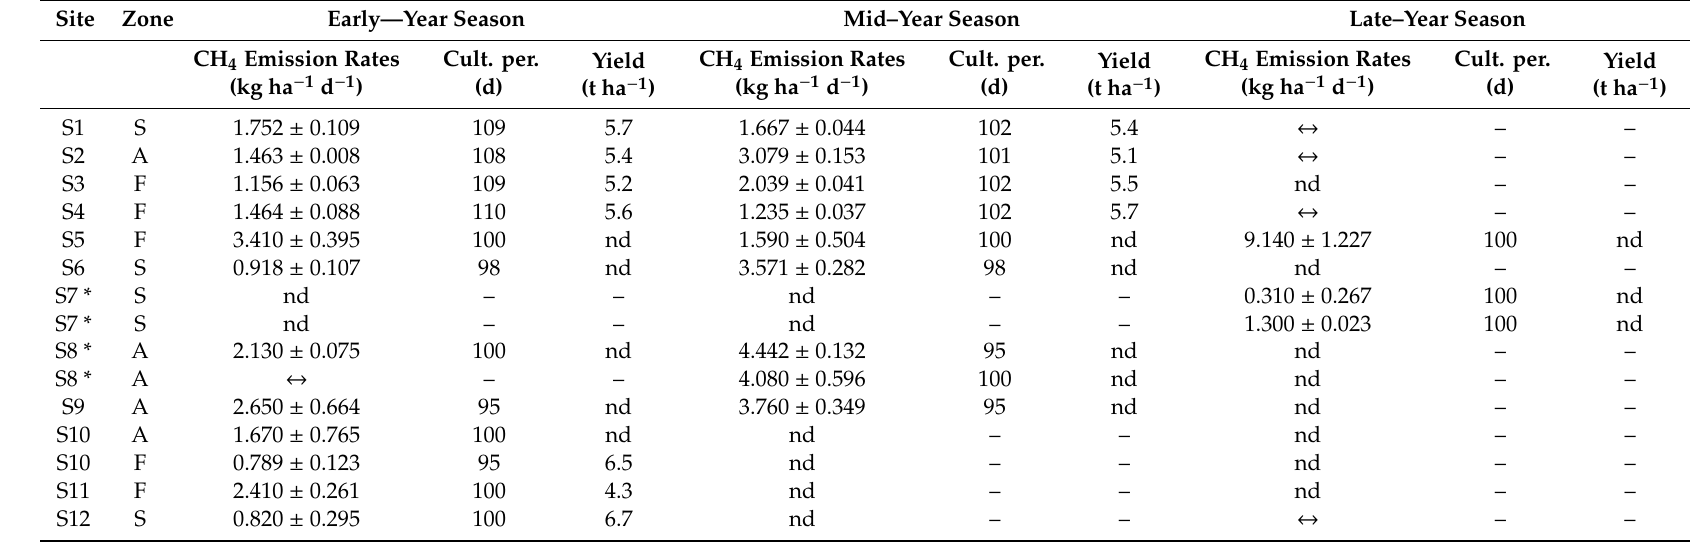
Table 3. Field measurements of daily CH 4 emission rates and cultivation period in South Vietnam. For site locations and zones, refer to Figures 2 and 3. (A—alluvial zone, F—deep flood zone, S—saline zone); Cult. per.—cultivation period; nd—not determined; ↔ —no rice crop grown; error—standard